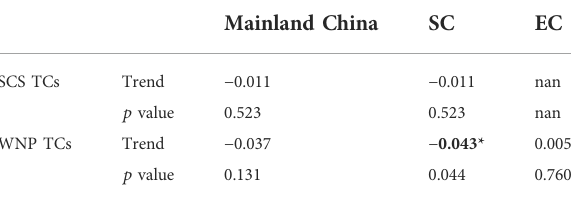
TABLE 3 The same as Table 1, but for the number of TCs generated in the SCS and WNP and made landfall over mainland China, SC, and EC from 1980 to 2020.